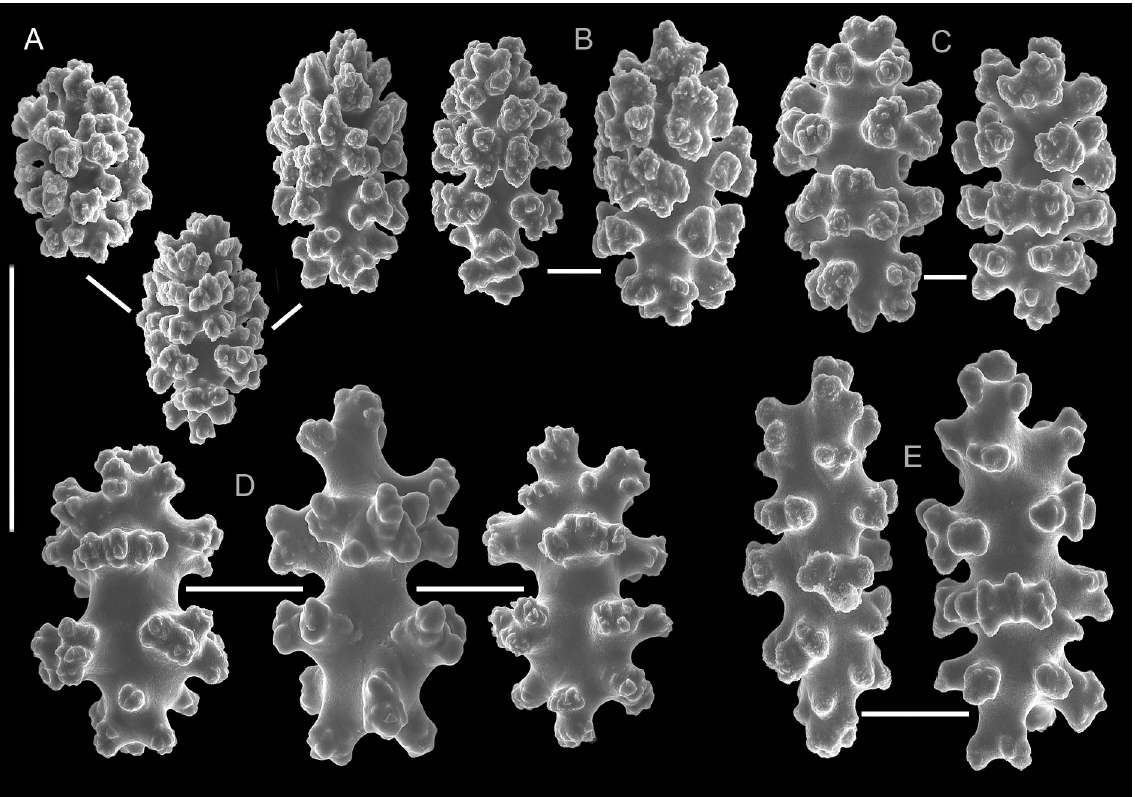
Fig. 10. Calcigorgia simushiri sp. nov., holotype (MIMB 20721), sclerites of the coenenchyme. A . Ovals. B . Capstans with unequally developed ends. C . Capstans (8-radiate sclerites) with symmetrically developed end with well calcified processes. D . Capstans (8-radiate sclerites) with less calcified processes. E . Spindles. Scale bar: 0.1